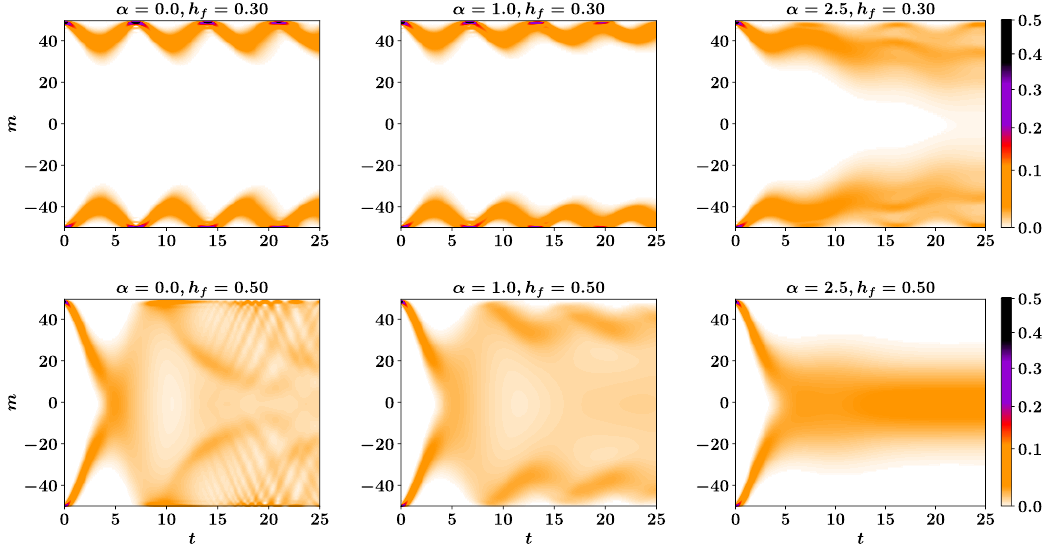
Figure 1: PDF dynamics of subsystem magnetization after a quantum quench for l = 100, α ∈ { 0.0,1.0,2.5 } and h